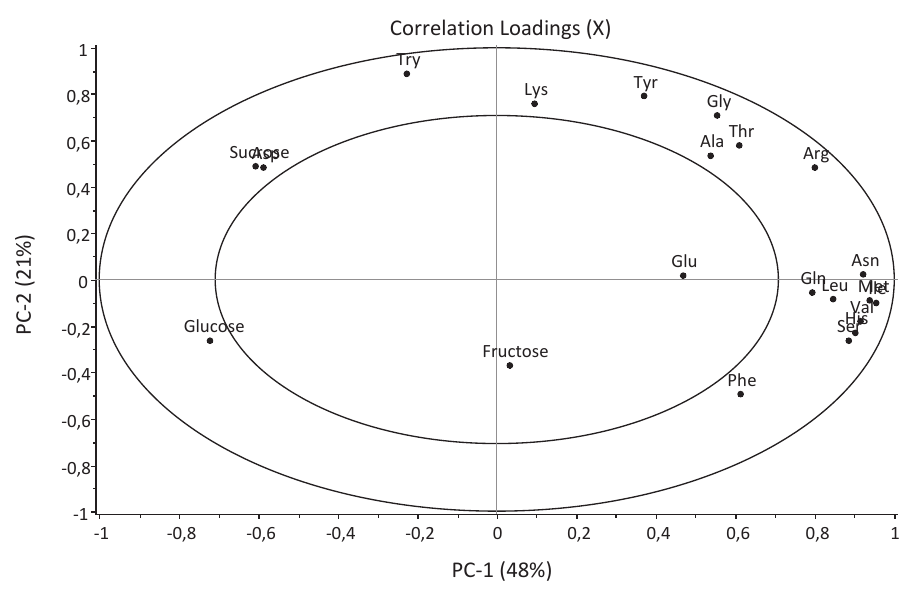
Fig. 2. PCA Correlation Loadings plot. Three sugars and 19 free amino acids are presented as